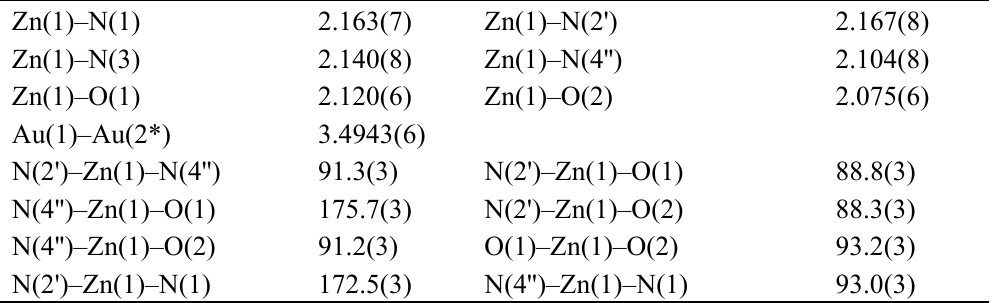
Table 3. Selected bond lengths (Å) and angles (deg) for Zn[Au(CN)